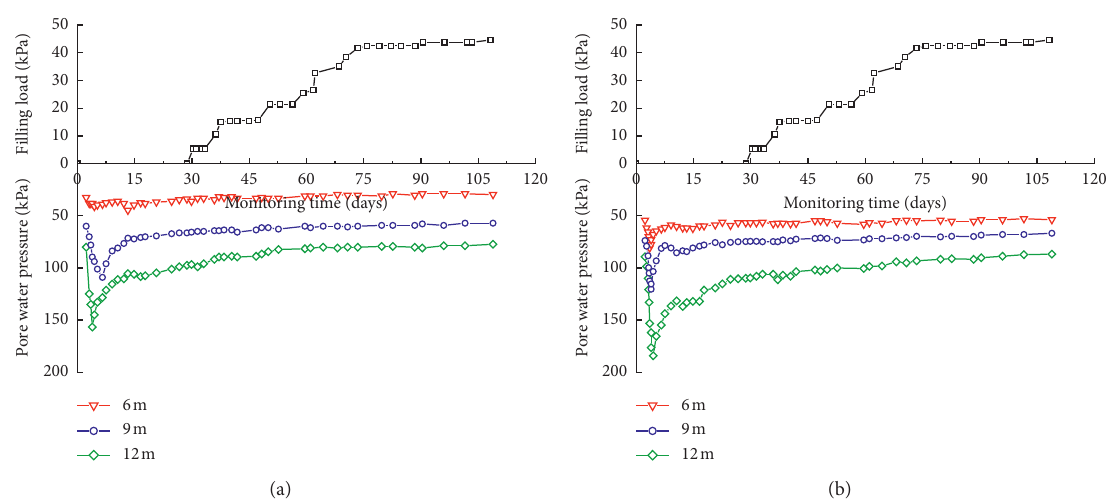
Figure 14: Variation of pore water pressure with filling load. (a) Left embankment. (b) Right embankment.